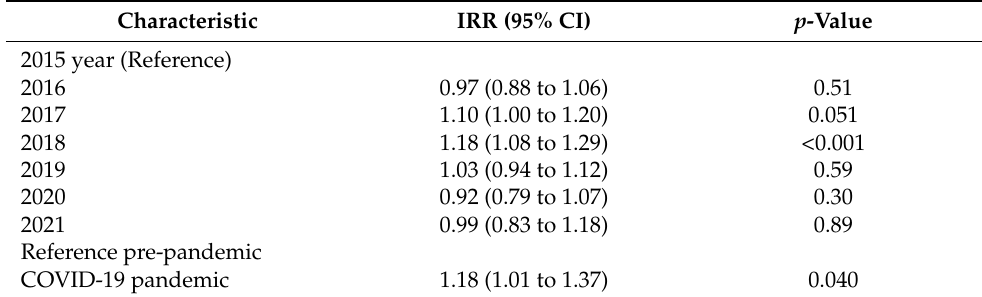
Table 6. Poisson model of rejection episodes corrected for number of transplants performed by year in Brazil’s Unified Healthcare System (SUS).